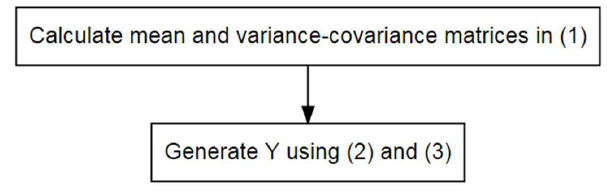
Figure 1. Procedure in applying